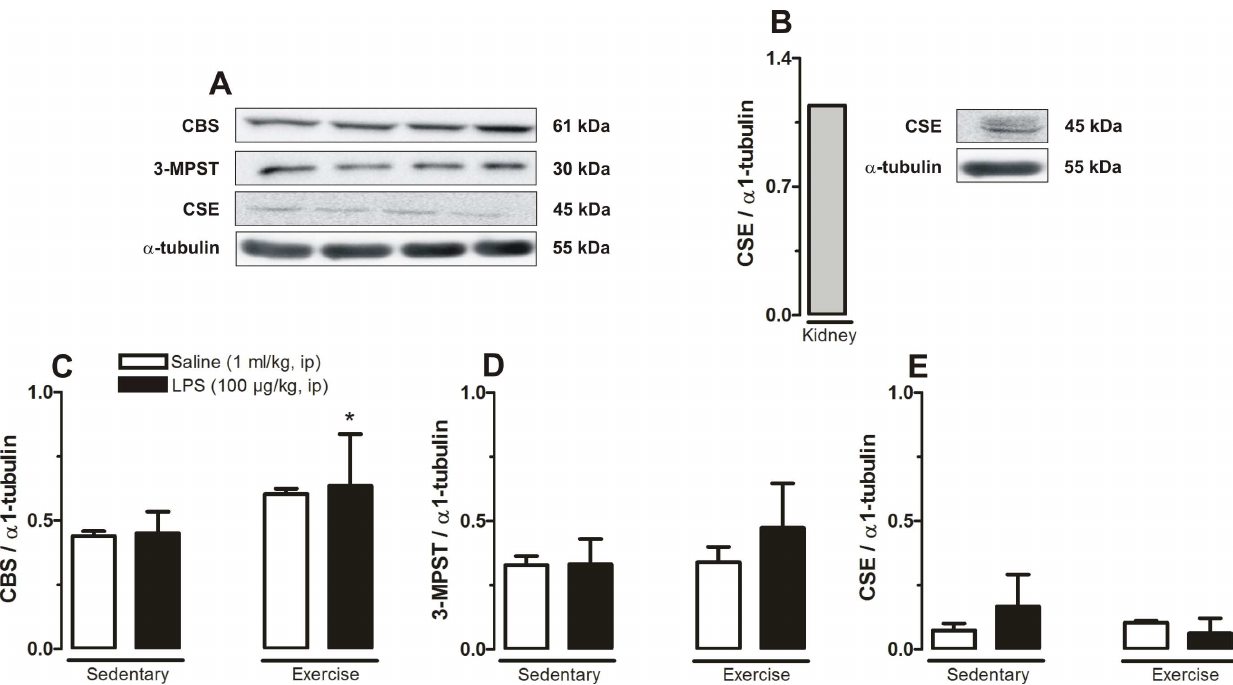
Fig 3. Relative proteins (CBS, 3-MPST and CSE) expression levels in the POA at 120 min after systemicadministration of LPS or saline. PainelA shows representative bands reflecting chemiluminescence signal intensity for studied proteinsof interest and loadingcontrol in each experimental group. PainelB shows the relative expressionand bandreflecting chemiluminescence signal intensity of CSE and loading control of the rat kidney, used as control. Results are expressedas relative expressionof CBS (C), 3-MPST (D) and CSE (E). Sedentarysaline (n = 7), Sedentary LPS (n = 7), Exercisedsaline (n = 6) and ExercisedLPS (n = 7). * P < 0.05,ExercisedLPS vs. SedentarySalineand Sedentary LPS.